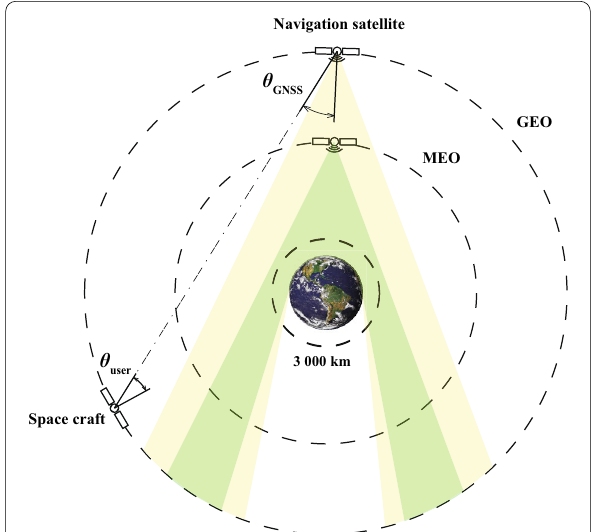
Fig. 2 Visibility between satellite and spacecraft and beam width of satellite signal at different